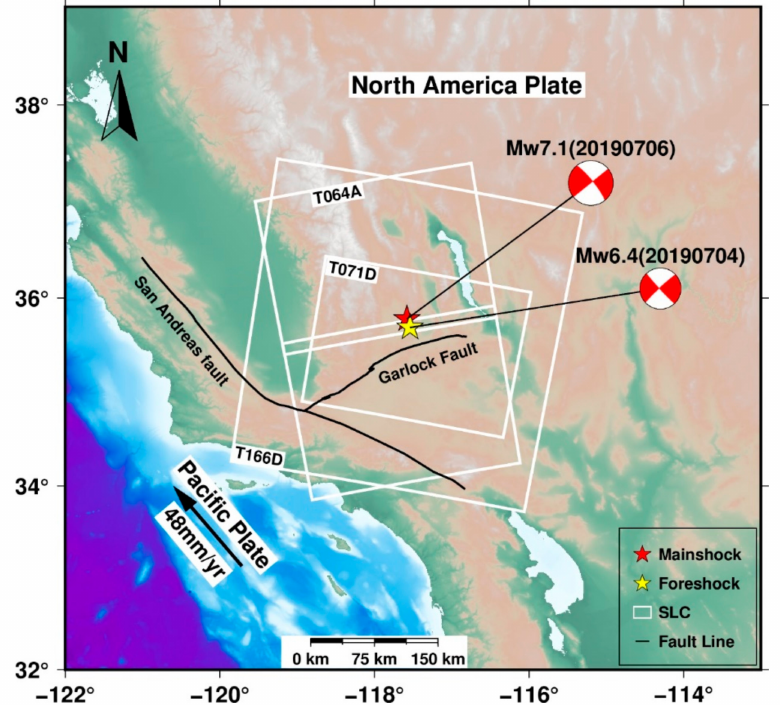
Figure 1. Study area tectonic setting. Red star represents mainshock epicenter, yellow star represents foreshock epicenter, and red and white circles represent the mainshock and foreshock focal mecha- nism solutions (from www.globalcmt.org (accessed on 3 February 2021)). The white rectangles mark the coverage of the synthetic aperture radar (SAR)